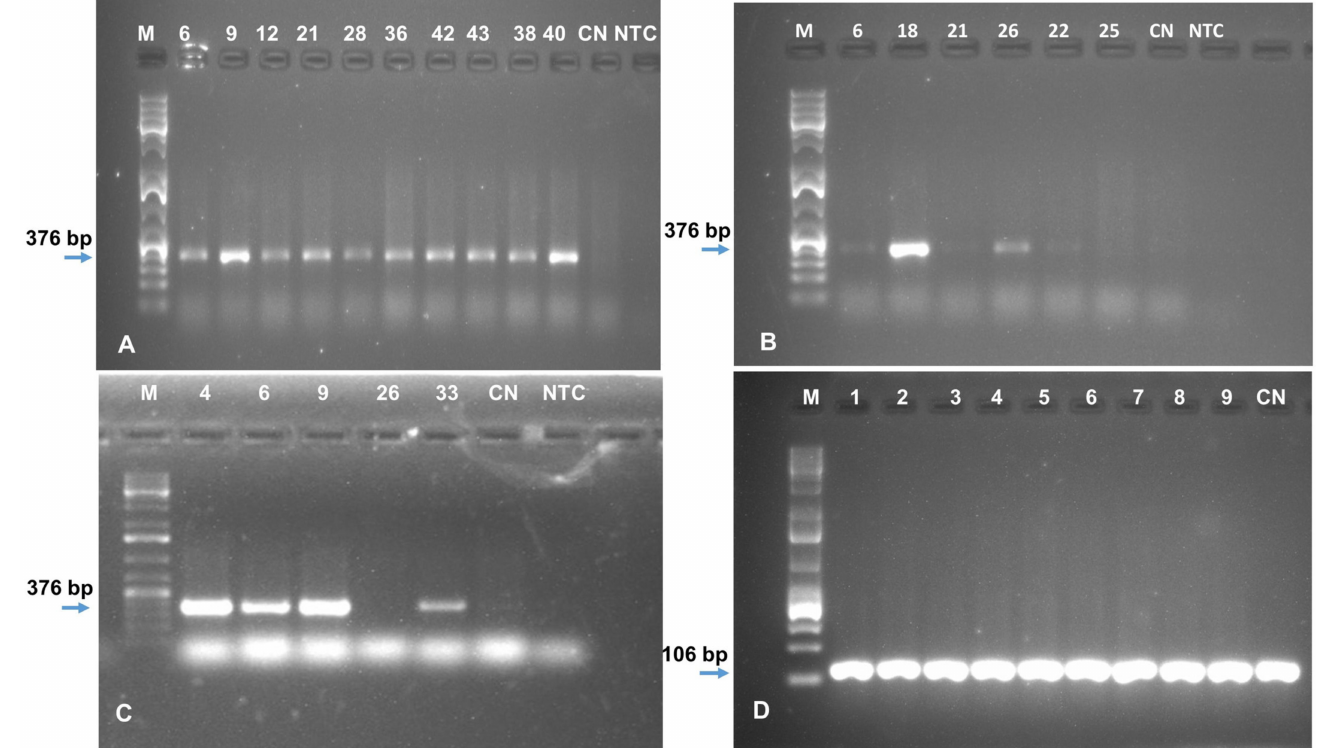
Figure 6. RT-PCR analysis to confirm expression of dsRNA- AChE in selected transgenic events. ( A ) Cavendish Williams, ( B ) Orishele, ( C ) Gonja Manjaya, ( D ) Musa 25S housekeeping gene in selected transgenic plants as an internal